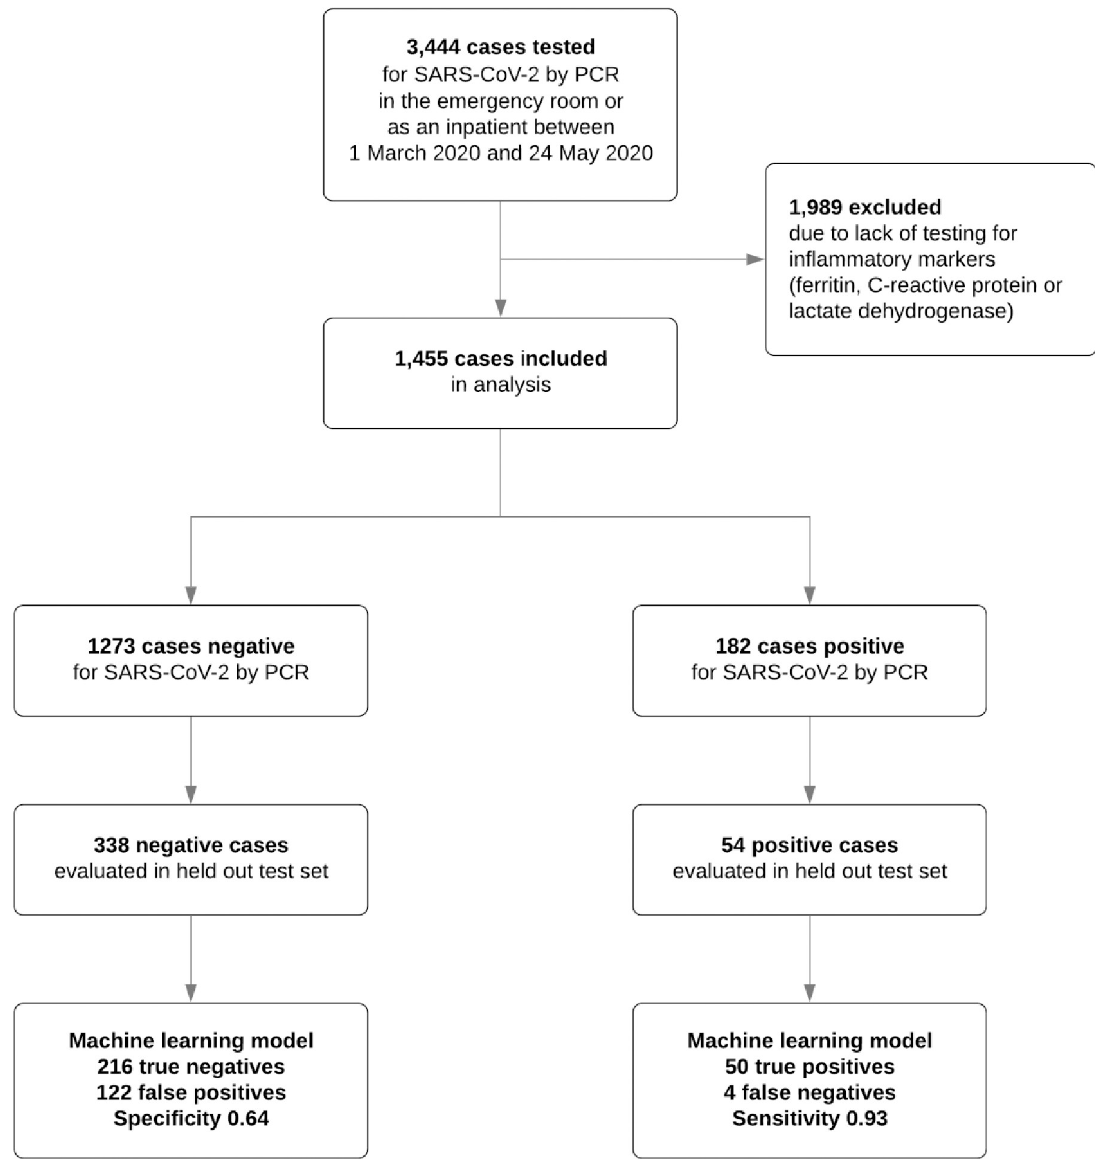
Fig 1. Diagram of eligible, included and excluded cases, and diagnostic cross tabulation.